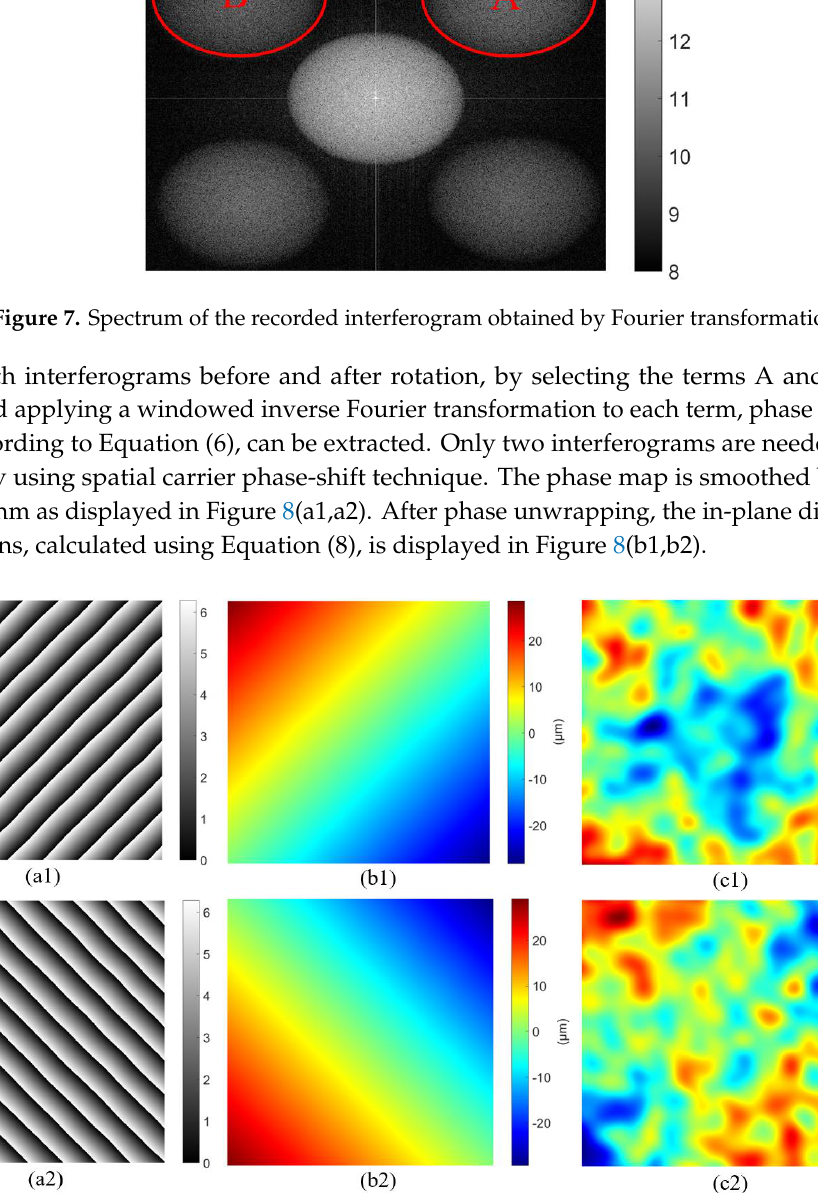
Figure 6. Enlarged view of the speckle pattern obtained using DSPI.